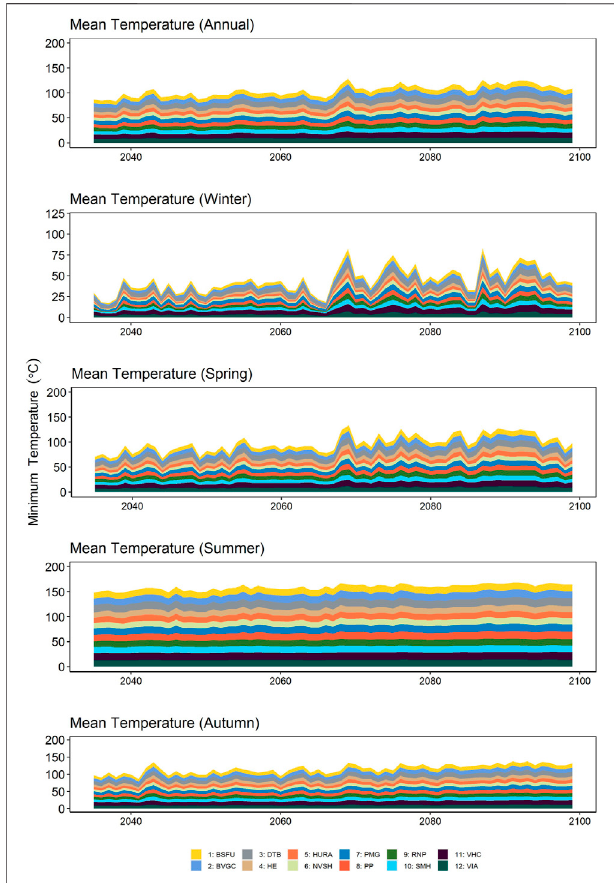
FIGURE 8 | Annual and seasonal time series ofprojected daily minimum temperature between 2035 and 2100.